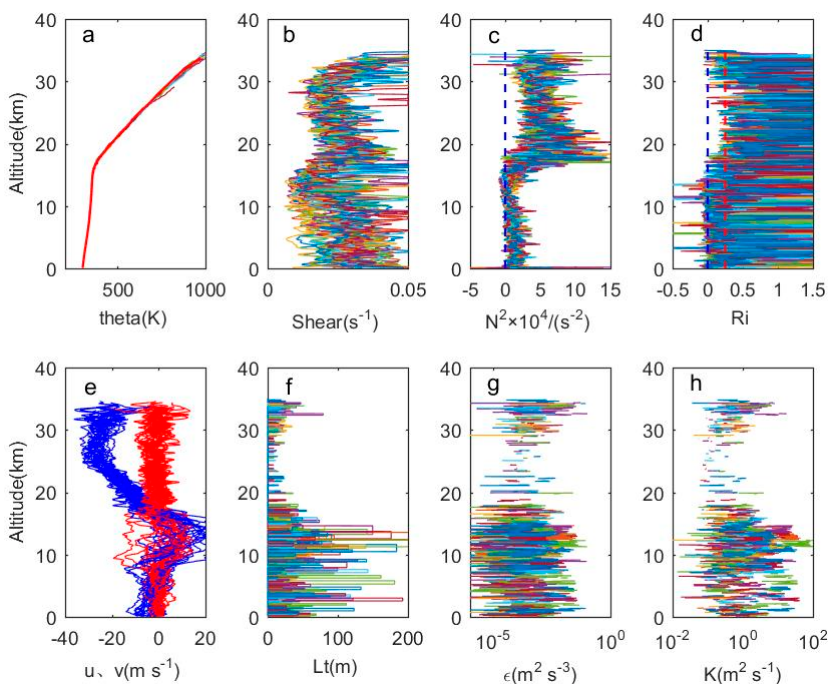
Figure 4. At 0012 UT on 10–31 May 2018 ( a ) temperature, ( b ) vertical wind shear, ( c ) buoyancy frequency, ( d ) gradient Richardson number, ( e ) wind speed component (zonal component: solid blue curve; meridional component: solid red curve), ( f ) Thorpe length, ( g ) energy dissipation rate, ( h ) diffusion coefficient.